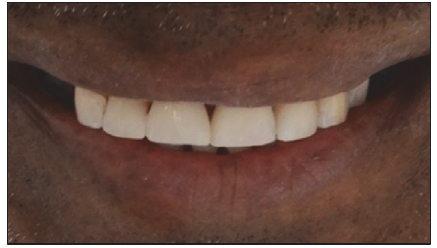
Figure 11: Postoperative extraoral view of the patient.